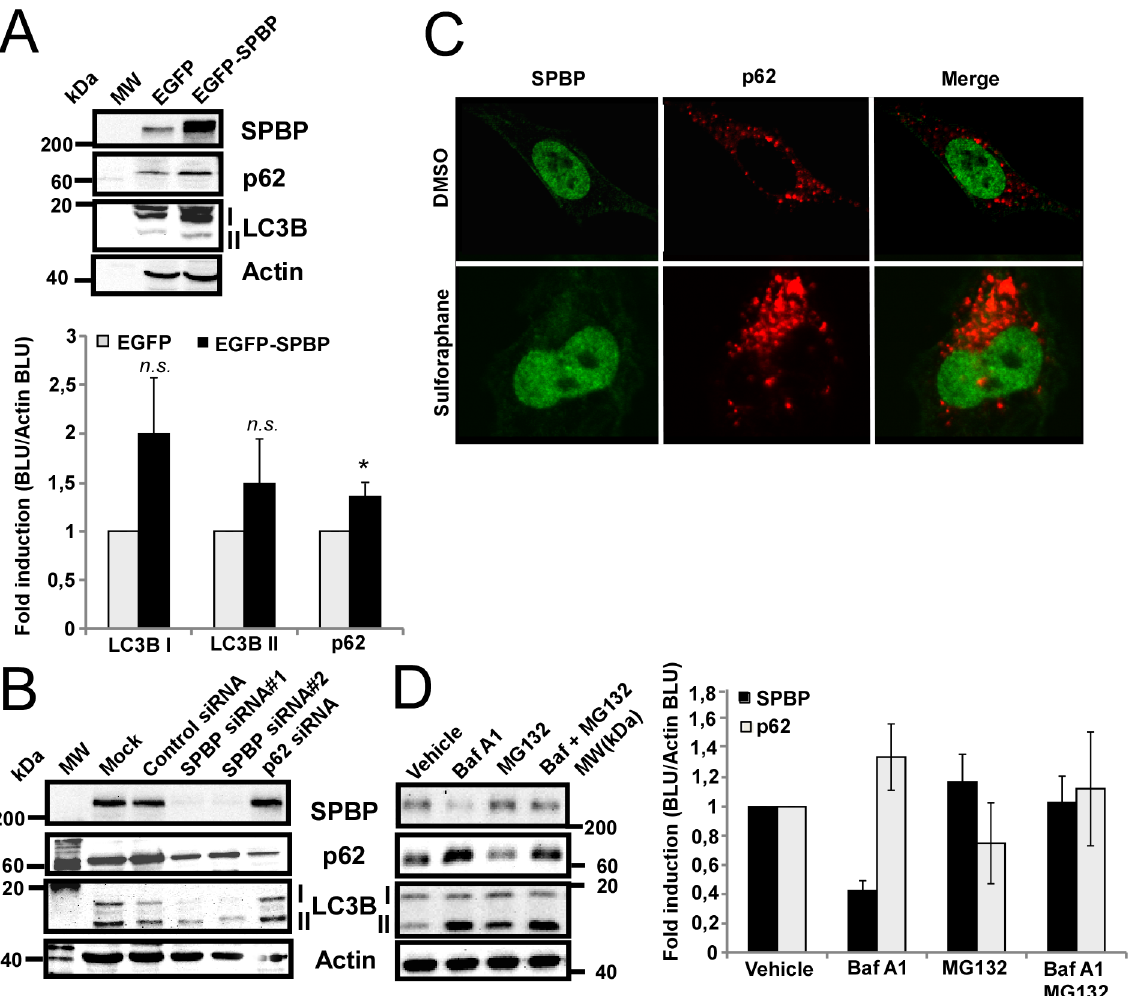
Figure 5. SPBP is not degraded by autophagy. ( A ) Over-expression of SPBP enhances the protein level of p62 in U2OS cells. Cell extracts of U2OS cells stably over-expressing EGFP or EGFP-SPBP were exposed to western blotting using the indicated antibodies. The graph shows fold induction calculated and correlated to actin in three independent experiments with standard deviations (*p , 0.05, n.s. not significant). ( B ) siRNA mediated knock-down of SPBP impairs LC3B expression. Cell extracts of HeLa cells transfected with SPBP siRNA, p62 siRNA or Control siRNA were subjected to western blotting using the indicated antibodies. ( C ) Endogenous SPBP is not recruited to p62 bodies upon sulforaphane treatment. HeLa cells were treated with DMSO (upper panel) or 20 m M sulforaphane for 8 hours (lower panel), fixed and stained with antibodies against SPBP (green) and p62 (red). ( D ) SPBP is degraded by the proteasome. Extracts from HeLa cells starved in HBSS (2 hours), left untreated or treated with Bafilomycin A1 (0.2 m M) or/and MG132 (0.2 m M) for 4 hours were subjected to western blot using the indicated antibodies. The graph shows the average quantification of the expression levels of p62 and SPBP obtained in two independent experiments.